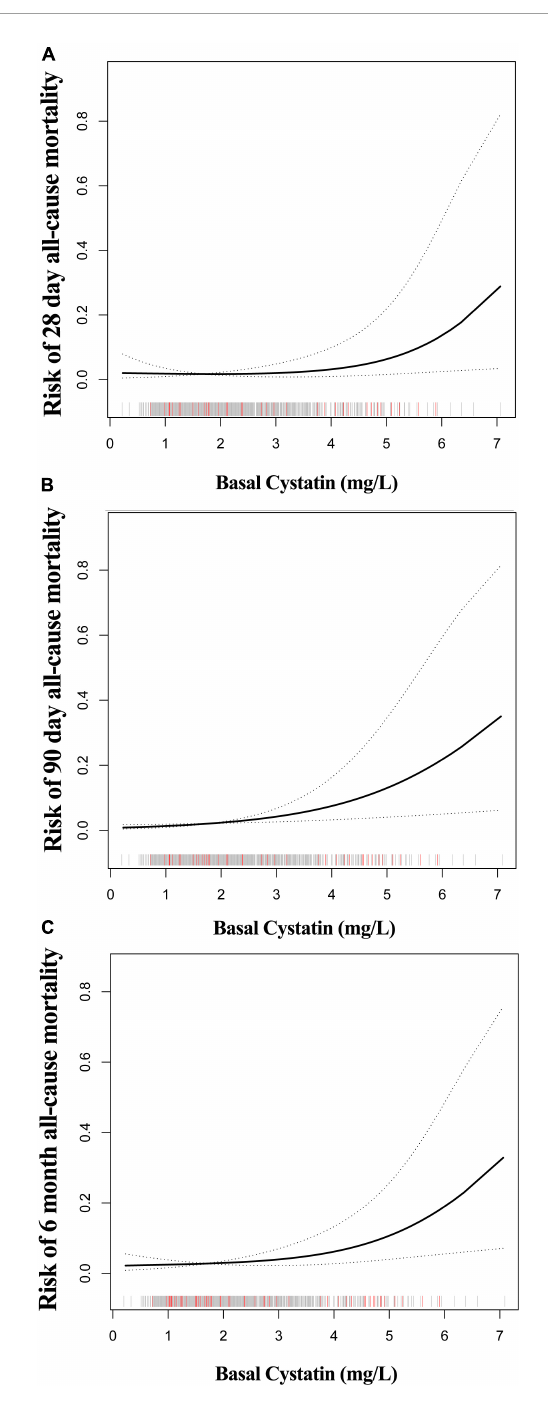
FIGURE2 The non-linear relationship between CysC and all-cause mortality of HF. The abscissa represents the CysC. The ordinates of figure (A–C) represent the risk of 28-day, 90-day, and 6-month mortality in patients with HF. The middle line represents the trend of all-cause mortality with CysC. The upper and lower lines represent the 95% confidence interval. The indicated lines on the x-axis represent each participant’s CysC level. The red line represents the patient who died. The gray line represents patients who have